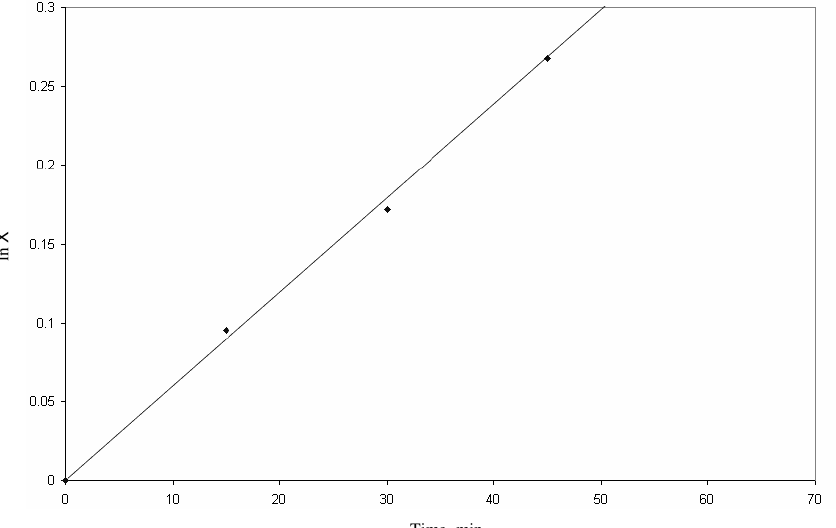
Figure 4. Represent calculation of diffusion coefficient (D) of PEG-Tannin